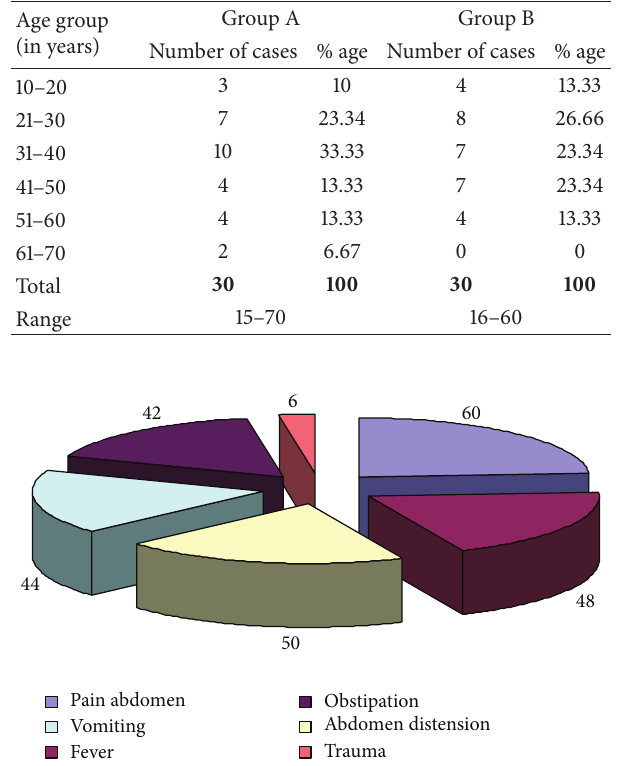
Table 1: Age distribution in both the groups.